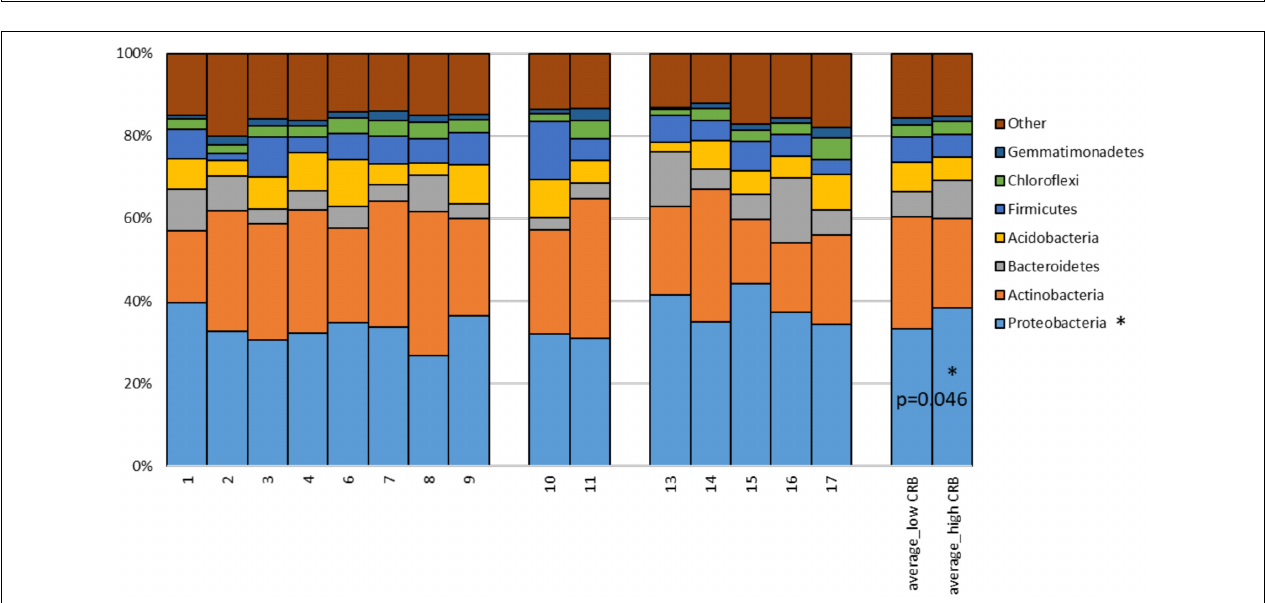
FIGURE 4 | UniFrac beta diversity analysis. (A) Principle coordinate plot based on weighted UniFrac. Number and color, respectively indicate farms and corresponding CRB status. (B) Box plot of UNIFRACp distances within and between groups.